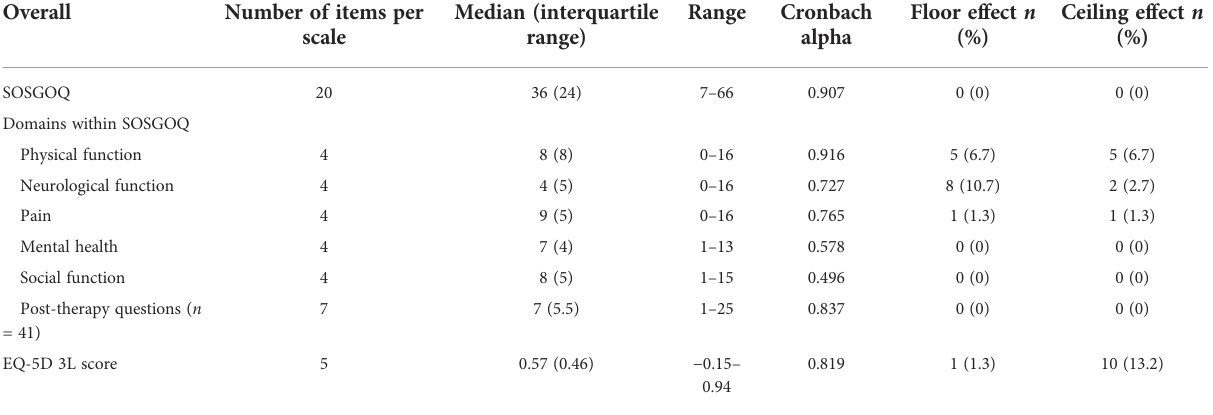
TABLE 2 Item completion rate, internal consistency, fl oor and ceiling effect, and score distribution per domain of the SOSGOQ and for the EQ-5D